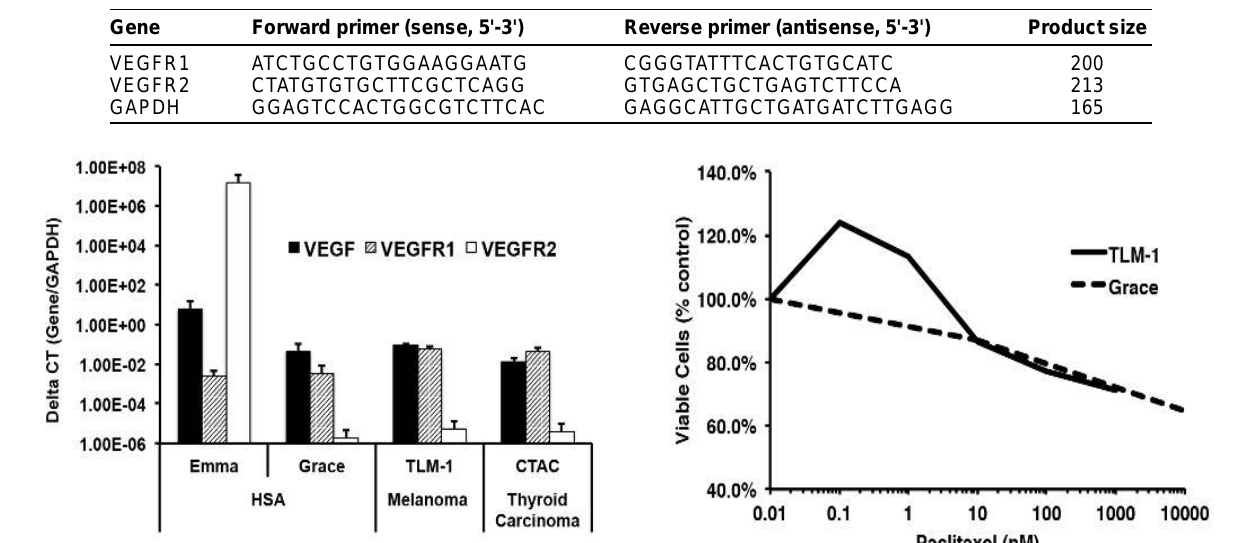
Figure-1. VEGFR expression was present in all canine cancer cell lines tested. RT-qPCR was performed using an Eppendorf Mastercycler ep realplex with FastStart SYBR Green Master Mix Protocol. Expression of VEGF, VEGFR1, and VEGFR2 was evaluated in Emma-HSA, Grace-HSA, TLM-1, and CTAC cell lines. Relative expression for each of these genes is shown normalized to GAPDH.